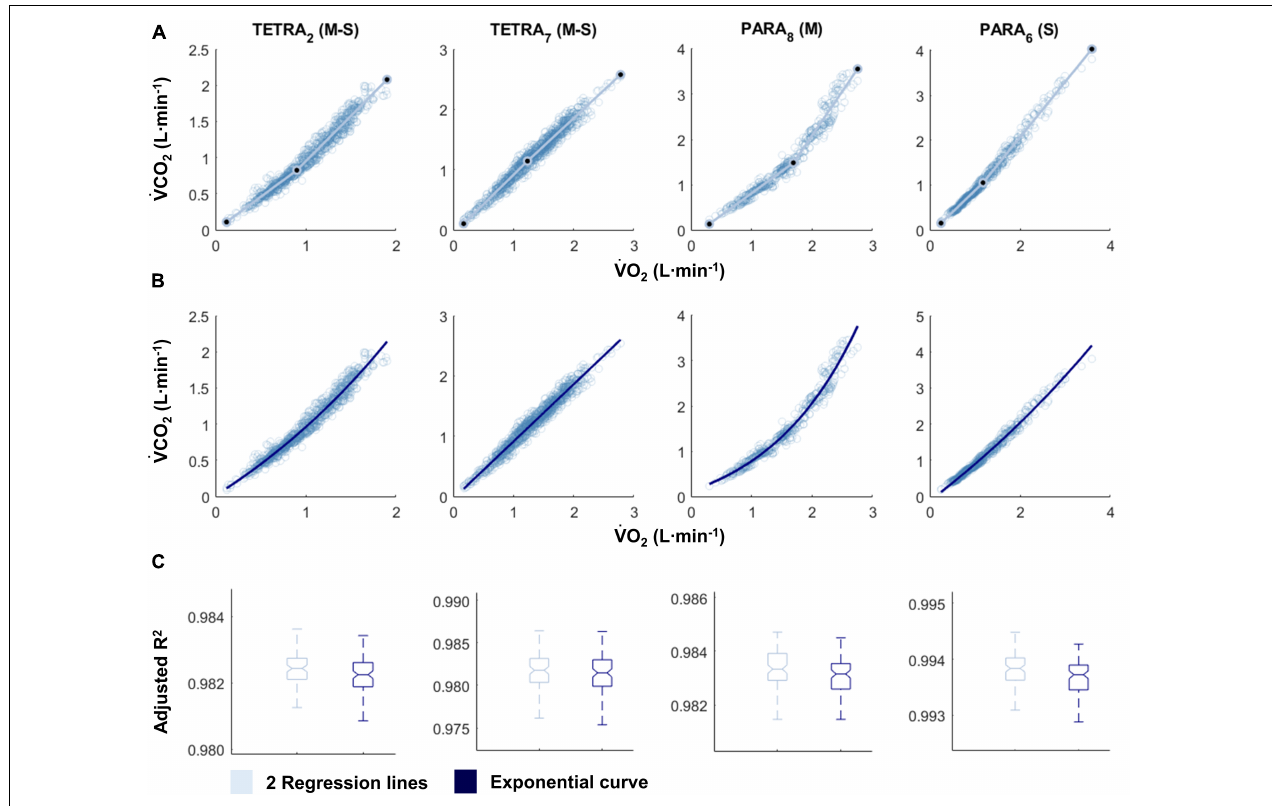
FIGURE 1 | ˙VO 2 -˙VCO 2 plots fitted with the two linear regression lines (breakpoint model, V-slope method; A ) and an exponential curve (no-breakpoint model; B ) for example athletes with tetraplegia and paraplegia who exhibit the most and least distinct breakpoint within their respective groups (TETRA 2 , TETRA 7 ; PARA 8 , PARA 6 ; participant number in subscript). Notched boxplots are presented to compare the adjusted R 2 values between the breakpoint and the no-breakpoint model for each participant (C) . Figures for all individual participants are provided in Supplementary Figure 2 . ˙VO 2 , Oxygen uptake; ˙VCO 2 , carbon dioxide production; TETRA, wheelchair athlete with tetraplegia; PARA, wheelchair athlete with paraplegia, M, motor complete injury; S, sensory complete